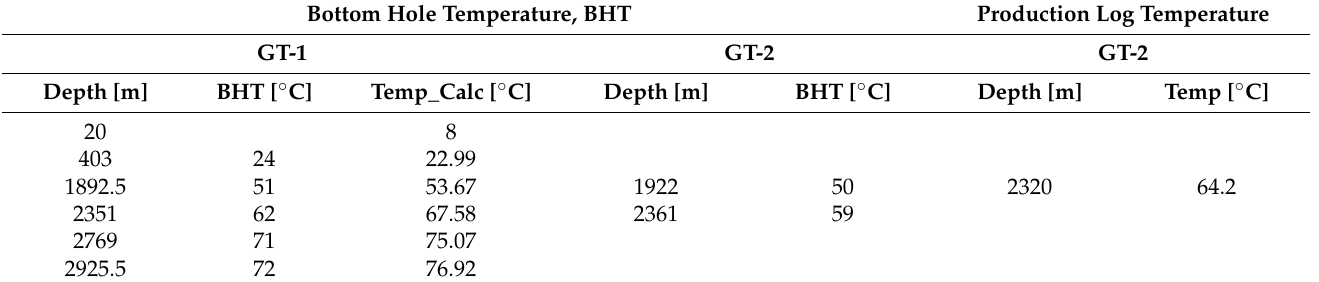
Table 3. Results of various temperature measurements in GT-1 and GT-2 boreholes.